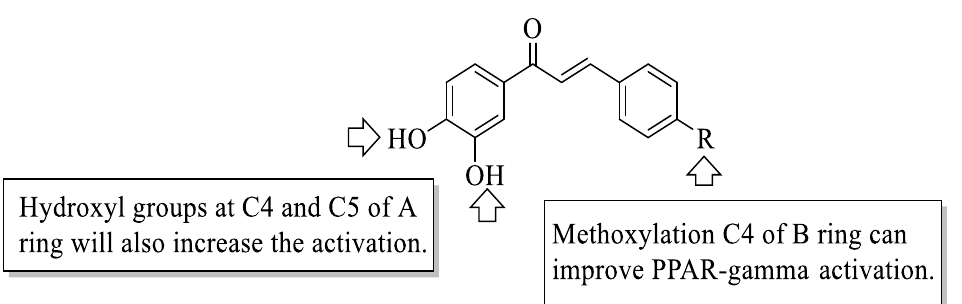
Figure 25. SARs of chalcones for PPAR-gamma activation activity [59].